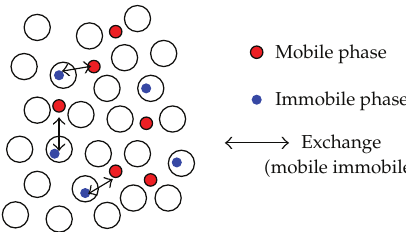
Figure 2: Mobile and immobile phase.